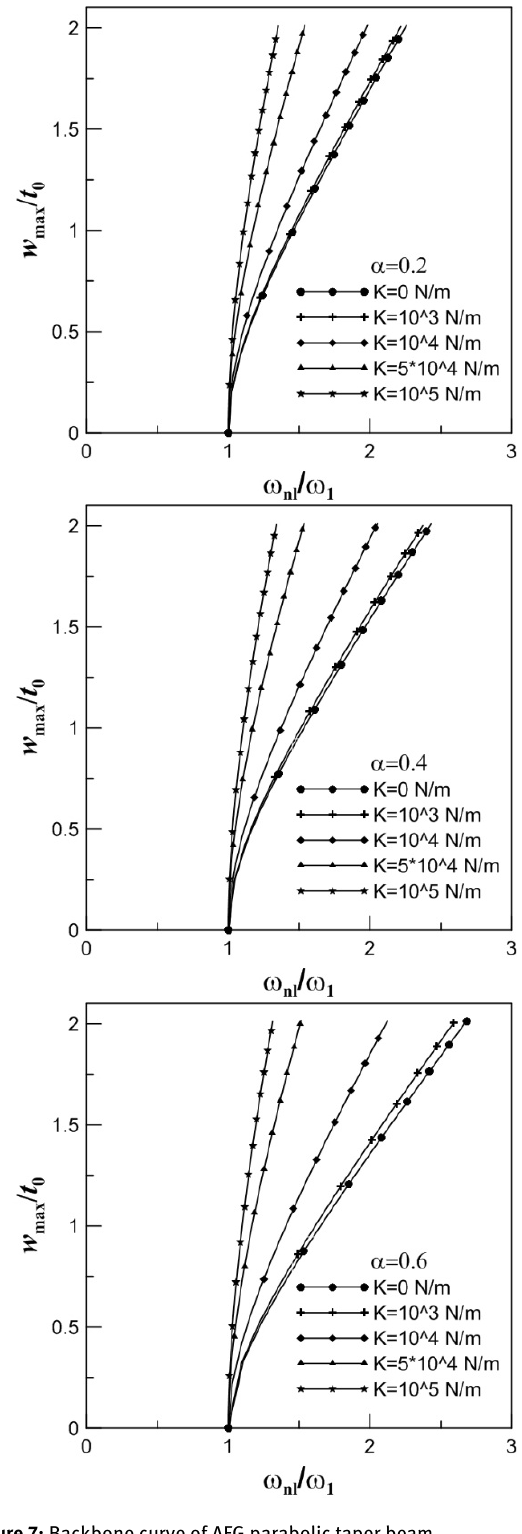
Figure 6: Backbone curve of AFG parabolic taper beam ( E ( ξ ) = E 0 , ρ ( ξ ) = ρ 0 ) on elastic foundation.